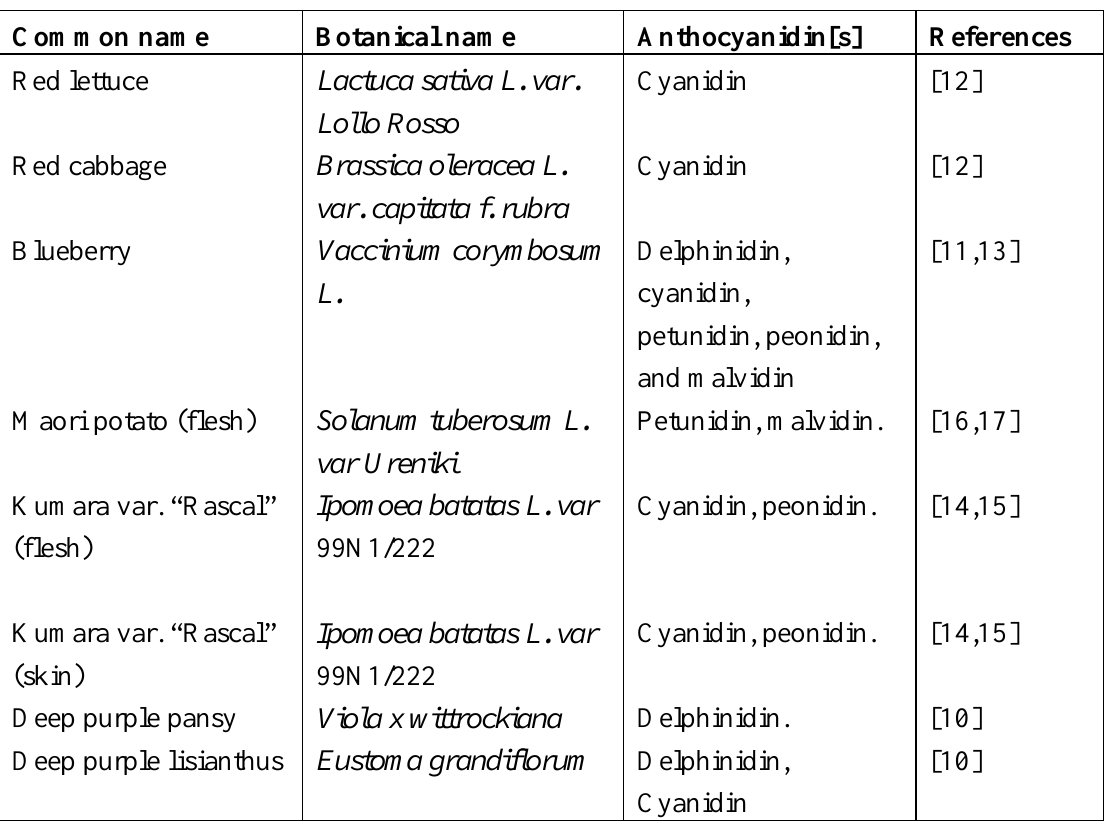
Table 1 . Botanical name and major anthocyanidins in some common